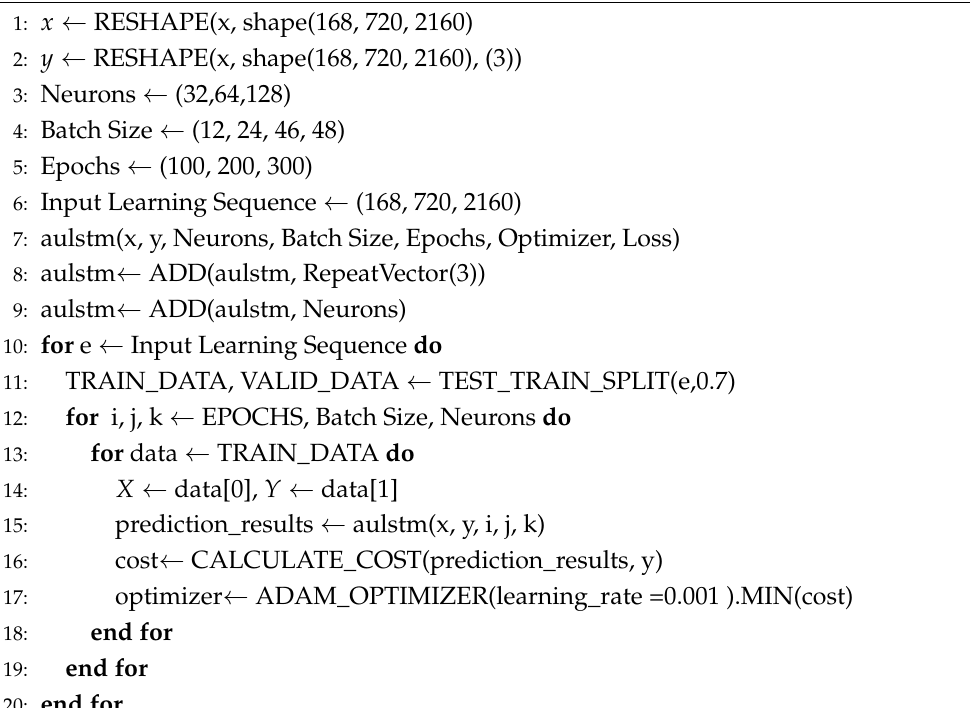
Algorithm 5 Autoencoder